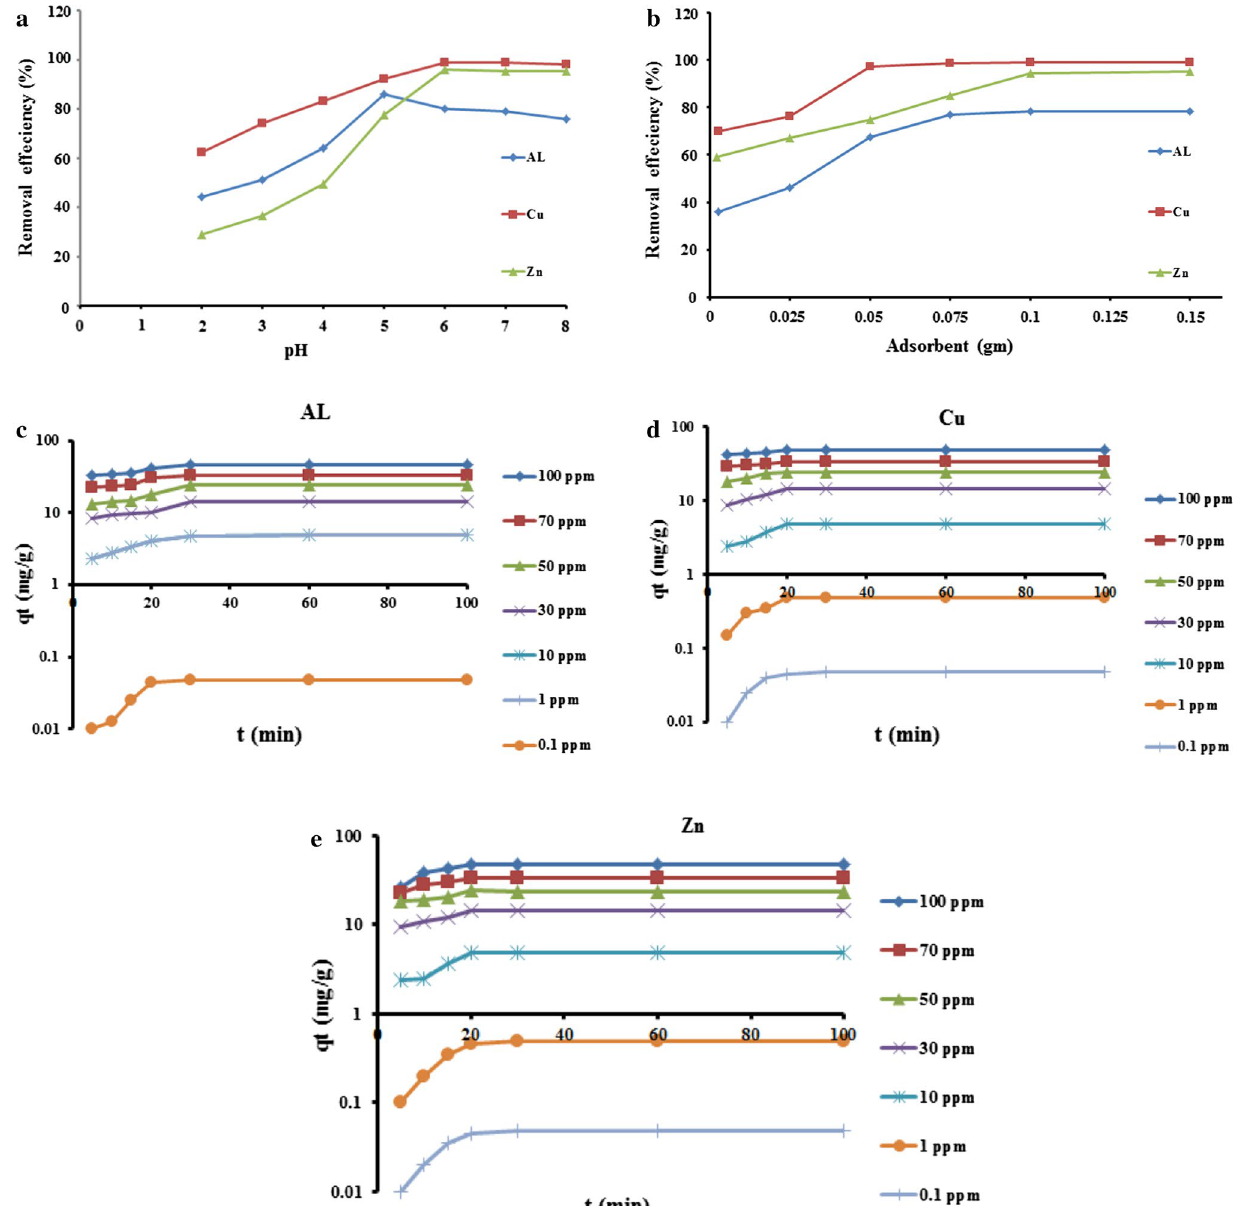
Fig. 9 Removal efficiency of Al(III), Cu(II) and Zn(II) on MZNCs. a Different pH values (100 ppm each, 0.1 g MZNCs, 24 h, 50 ml); b different adsorbent mass (100 ppm each, ambient pH, 24 h, 50 ml); c adsorption of Al(III) in solution with different initial concentrations